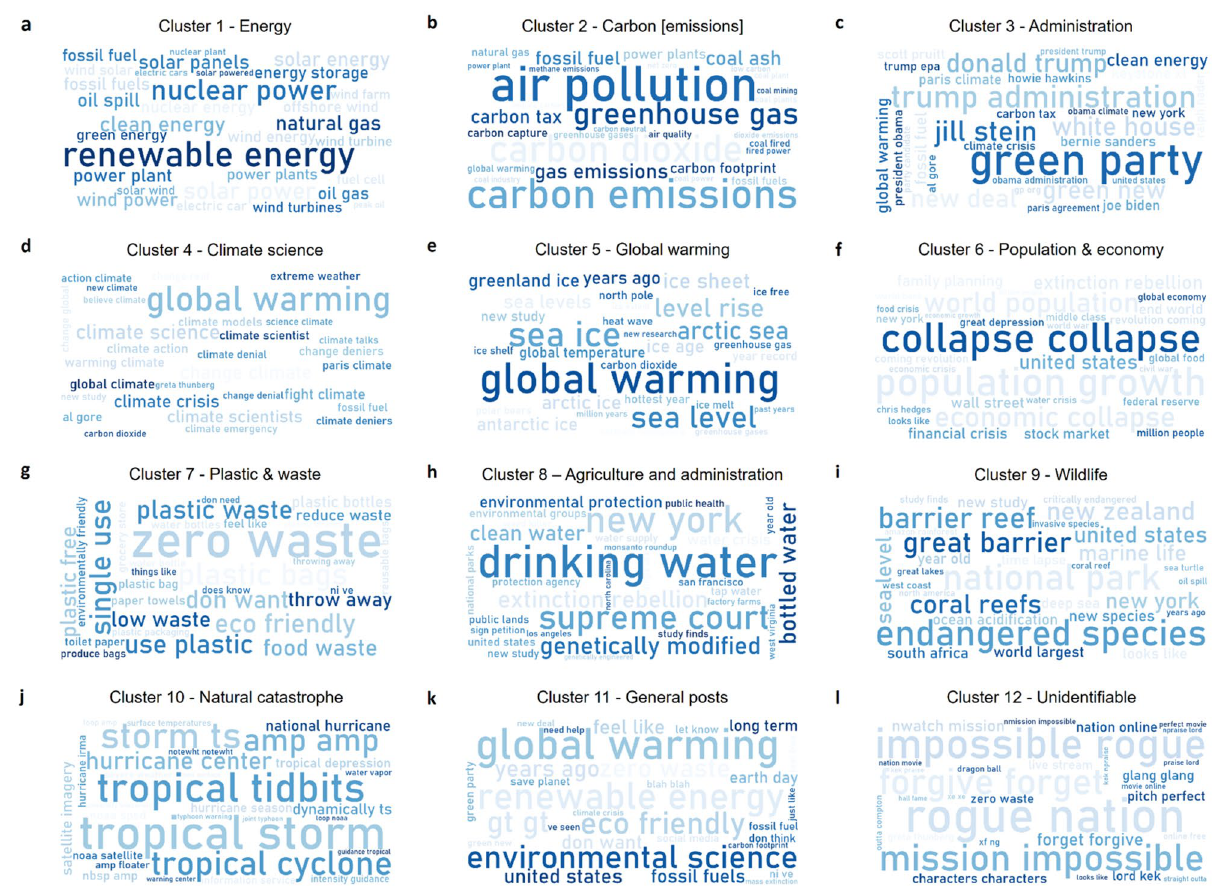
Figure 7. Sample 1 final optimized clusters in word clouds 50 . The word cloud for a given optimized cluster has been generated from top 30 bigrams 68 featured in that cluster sorted by Tfidf-Vectorizer 69 weights. It provides a bird’s view into the underlying keywords belonging to all 12 clusters ( a – l ), specifically showing how distinguished the optimized clusters are in terms of their composition. For instance, “global warming” features in clusters 4 & 5 both ( d , e ), however by observing the other bigrams within the respective word clouds, we see that words like “climate science/scientists”, “climate denial” etc. dominate the Climate science cluster ( d ) while “sea ice”, “level rise” etc. - mainly the impacts of global warming - dominate the Global warming cluster ( e ). Moreover, we observe a clear distinct group of bigrams belonging to each optimized cluster thereby expressing the underlying theme distinctly except for General posts ( k ) and Unidentifiable ( l ) clusters. While the General posts cluster ( k ) contains mainly Reddit posts belonging to a wide range of themes of climate as opposed to discussing a specific theme as observed in other identified clusters, the Unidentifiable cluster ( l ) mostly contains posts which are having discussions of other than climate and thus do not belong to any specific climate theme or